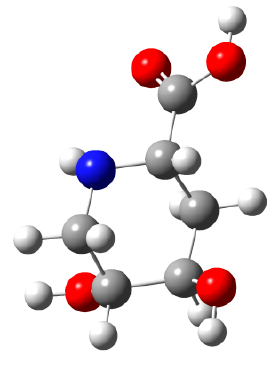
Figure 5. Minimum energy conformation of target compound 1 calculated by DFT (Gaussian 9.0)